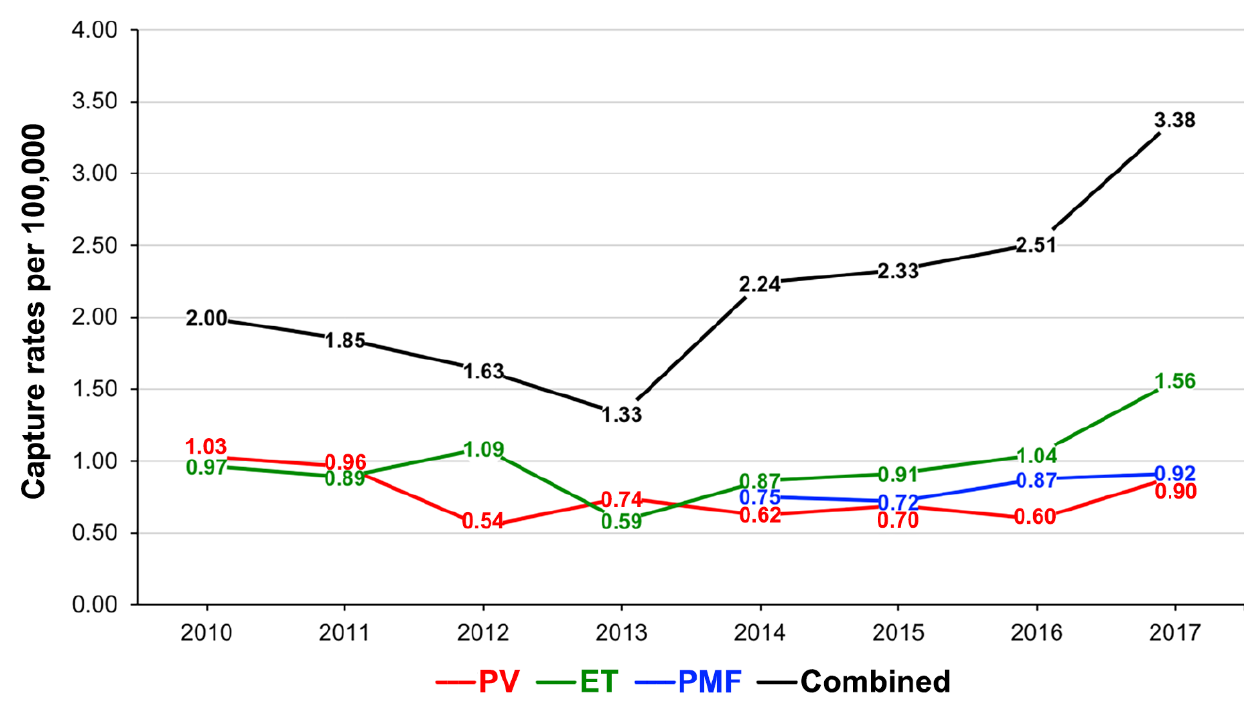
Figure 1. New Zealand Cancer Registry capture rates of classical Ph-negative myeloproliferative neoplasms (MPNs). Capture rates by the New Zealand Cancer Registry are shown per year for all MPNs, PV, ET and PMF, from 2010 to 2017. N.B. PMF registrations started in 2014. PV, polycythaemia vera; ET, essential thrombocythaemia; PMF, primary myelofibrosis.